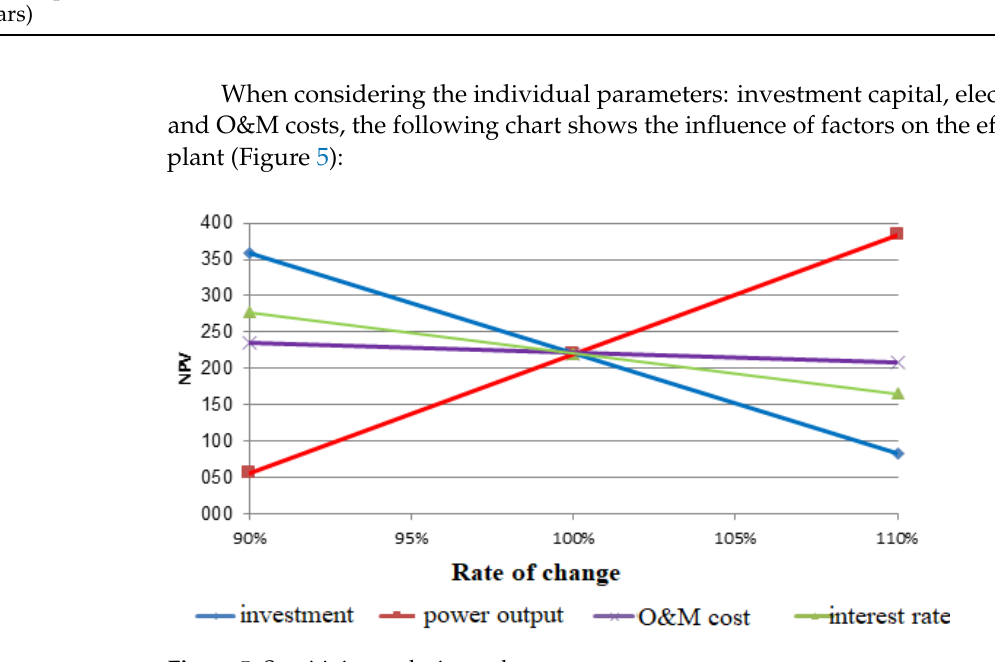
Table 8. Sensitivity analysis results.